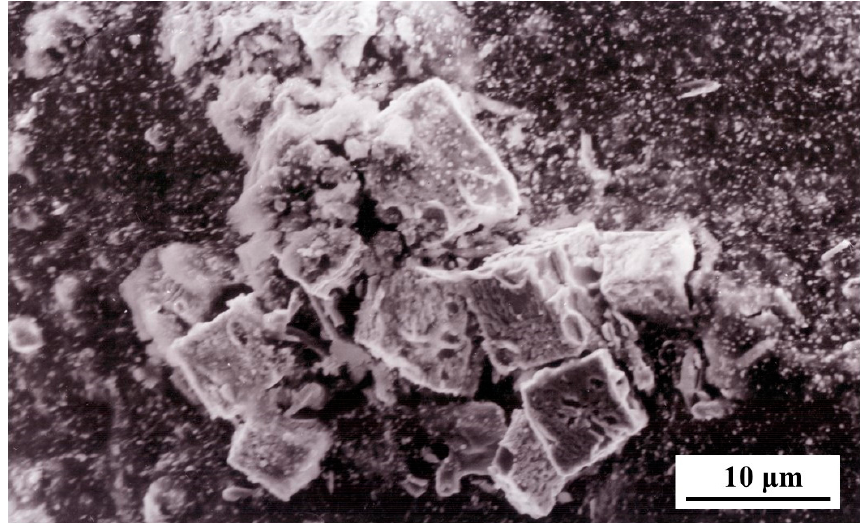
Figure 9. SEM image of the carbides extracted after the heating step at 873 K.